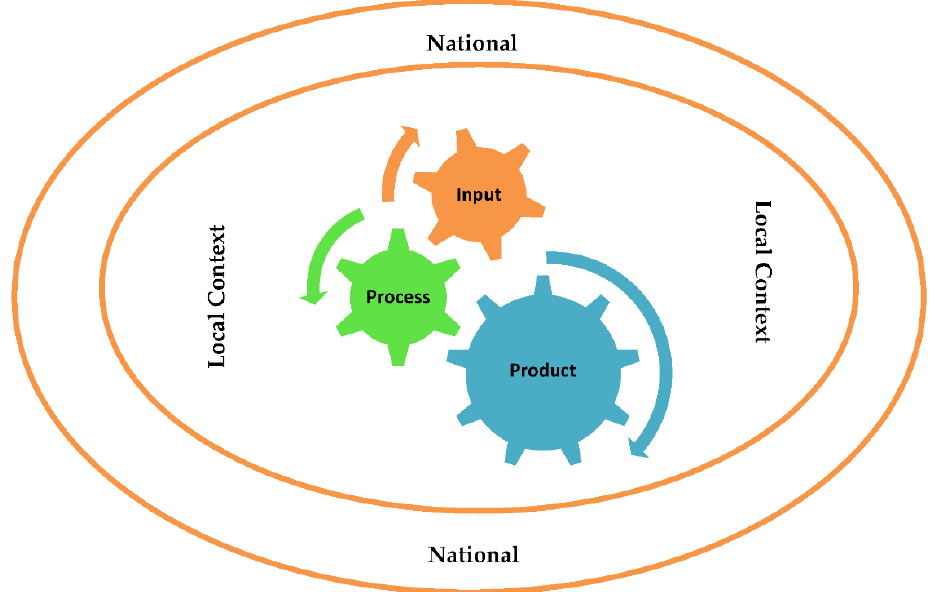
Figure 1. An innovative framework for evaluating youth volleyball programs. Source: Stufflebeam, D., Madaus, G. F., & Kellaghan, T. (2000) Evaluation models [22].